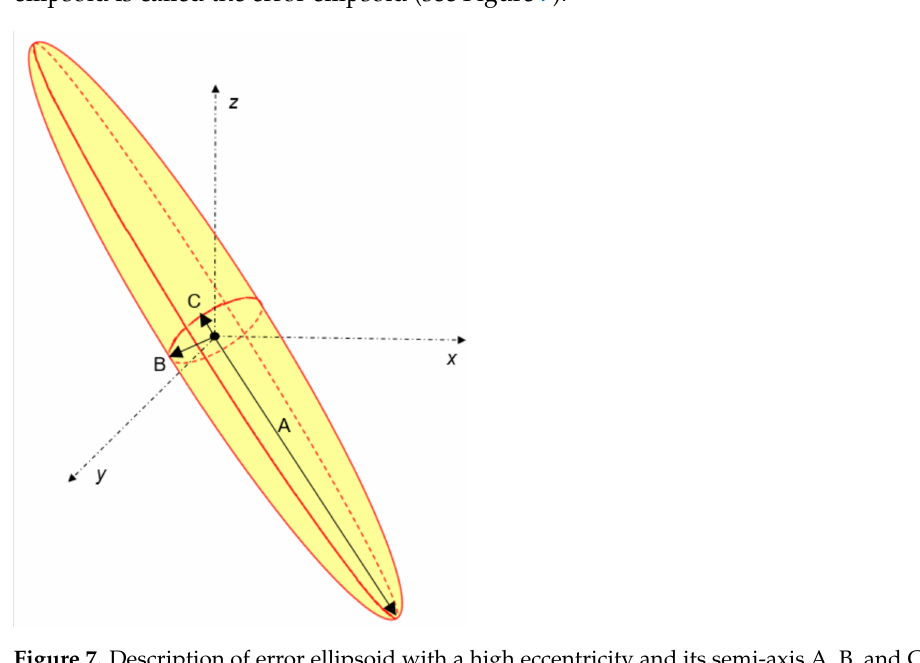
Figure 7. Description of error ellipsoid with a high eccentricity and its semi-axis A, B, and C. The ellipsoid parameters (the lengths of the semi-axes and their angles of